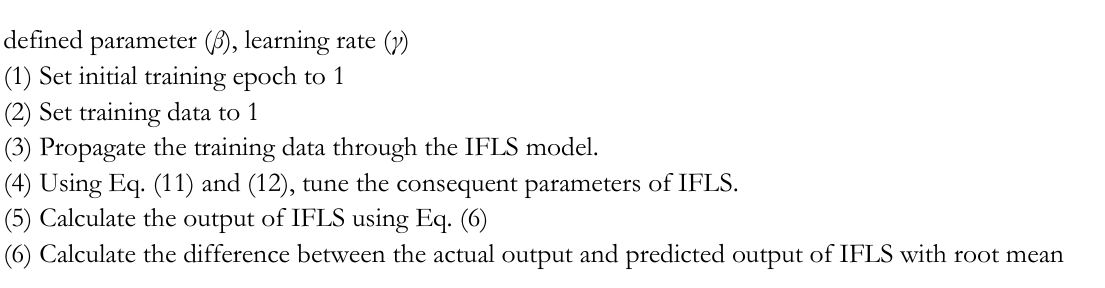
Algorithm 1 : IFLS-GD Learning